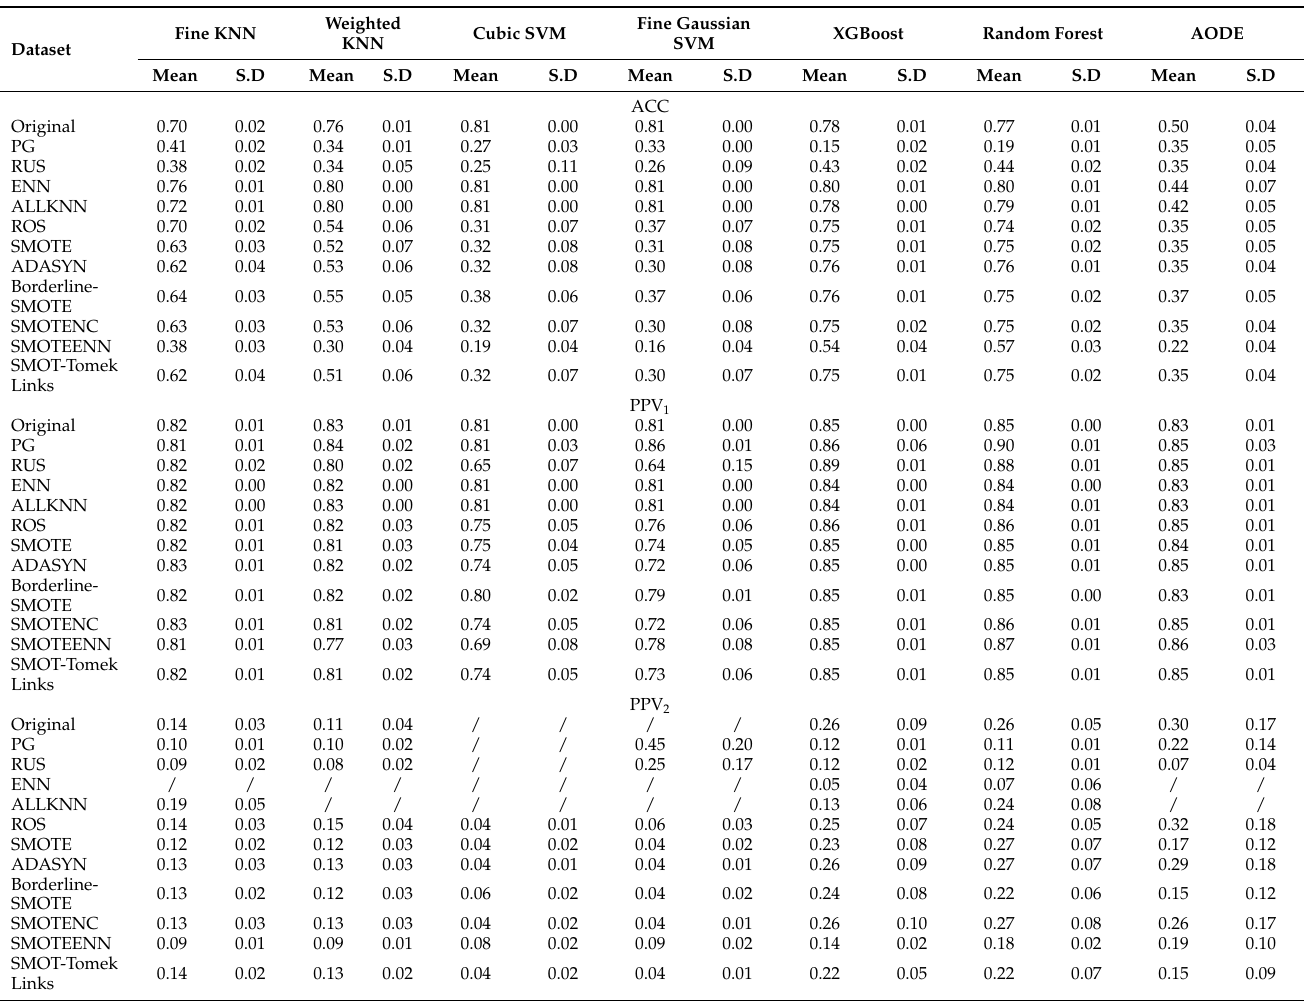
Table A1. Comparison between the different models using performance